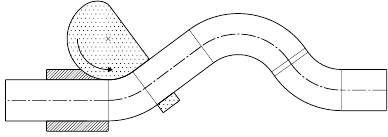
Figure 3. Rotary draw bending process because every bend is bend around the same die. If the distance between two bends is to 164 short to retain the pipe by the rotating dies the pattern of the pipe needs to be milled 165 into a specific bending claw. 166